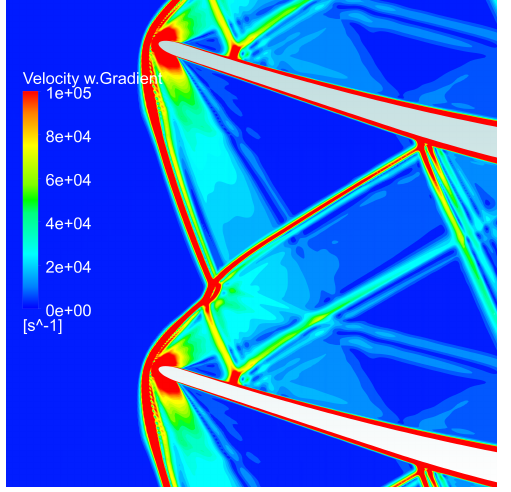
Figure 21. Mach phenomenon generated by the intersection of rotor bow-shock waves in design point